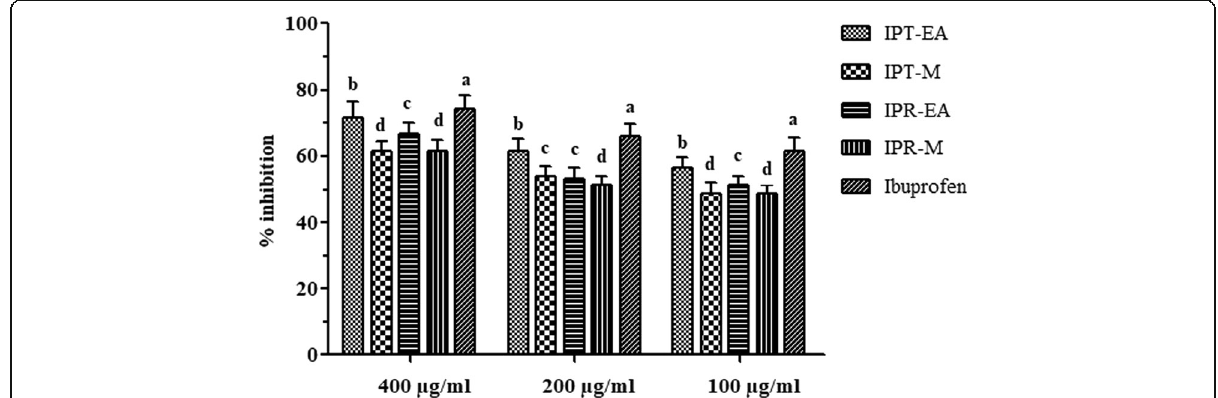
Fig. 4 In vitro antiinflammatory assessment of I. batatas extracts via albumin denaturation. Each value is represented as mean ± SD ( n = 3). Means with different superscript (a-d) letters in the column are significantly ( p < 0.05) different from one another